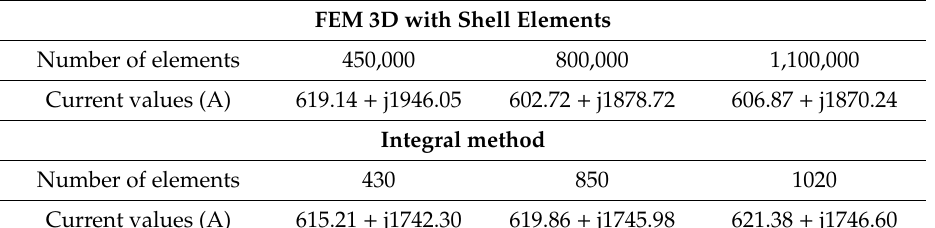
Figure 7. Geometry of the test case “Folies”.